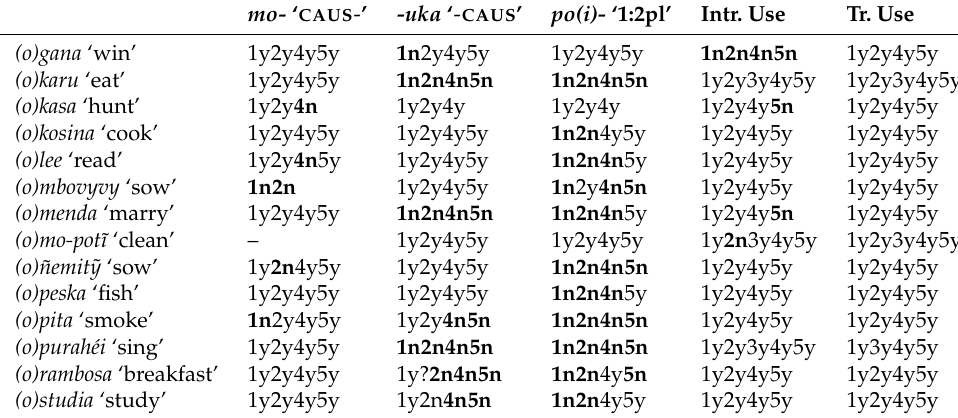
Table A3. Judgments for verbs that pattern like ambitransitive verbs.